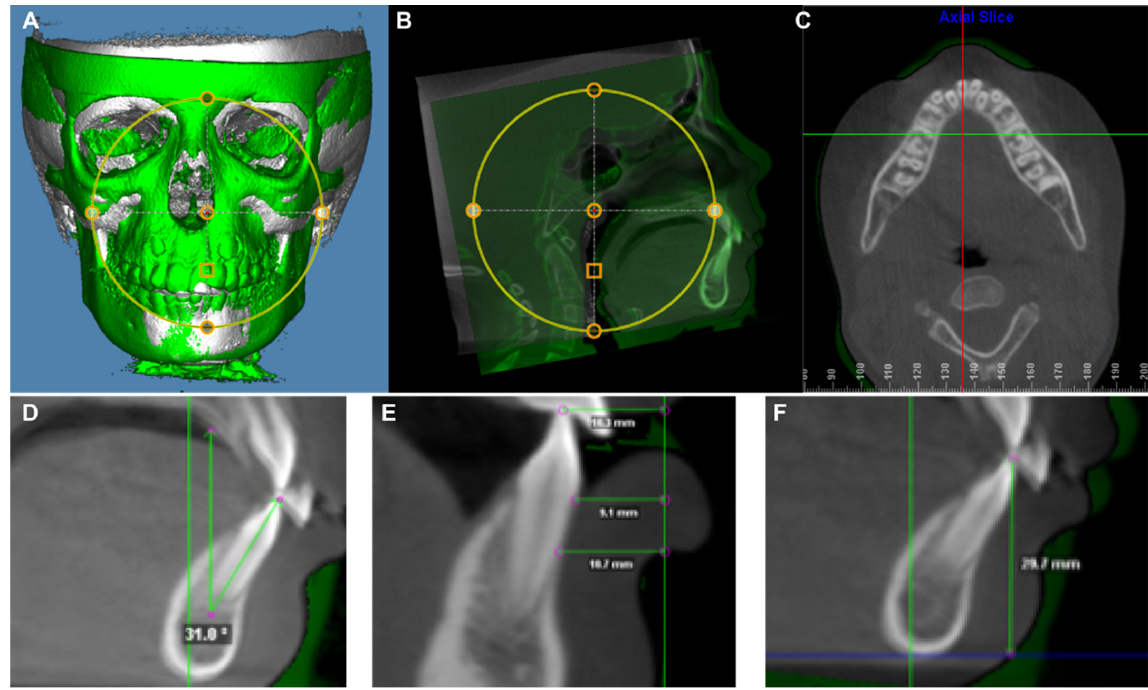
Figure 1. The demography of CBCT image analysis utilized in current study. ( A ) A screenshot of the superimposition of T1 and T2 CBCT images in a 3D reconstructed view. Th T1 CBCT image is represented in white and the T2 CBCT image is presented in green. ( B ) A screenshot of the superimposition of T1 and T2 CBCT images in midline sagittal slice view. The superimposition was performed based on the mandibular structure. The T1 CBCT image is represented in white and the T2 CBCT image is presented in green. ( C ) The axial slice was used to find the sagittal slice (red line) that was a best fit through the center of the mandibular central incisors. ( D ) Mandibular central incisor inclination measurement on the sagittal slice: Best fit line from tip of incisor through root apex measured to true vertical. ( E ) Mandibular central incisor protrusion measurement on the sagittal slice: The buccal surface of the tooth to true vertical line established at 10 mm ahead of the T1 symphysis (green vertical line). ( F ) Mandibular central incisor vertical position measurement on the sagittal slice: Tip of incisor to true horizontal line established at the T1 inferior border of symphysis (blue line). The vertical position of the mandibular incisors was measured by the distance between the incisal edge and the true horizontal line established at the T1 inferior border of sym- physis. Both T1 and T2 incisor vertical position were measured to the T1 true horizontal line to eliminate the difference of the inferior border of symphysis between T1 and T2 due to the normal growth and development of the mandible. Over the time period, a positive value was indicative of an eruption while a negative value was indicative of an